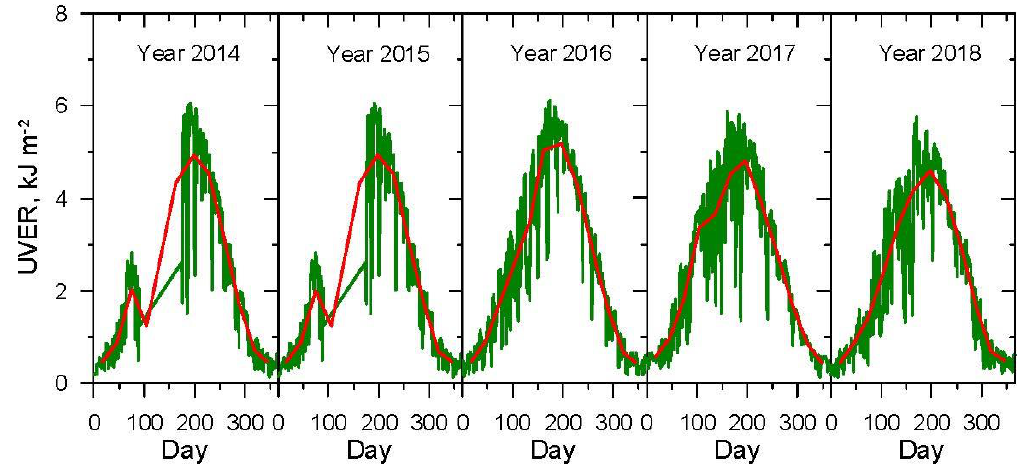
Figure 2. Yearly evolution of monthly average (red) and daily (green) UVER solar irradiation values, (kJm −2 ) in Valladolid, Spain, for the period 2013–2019.